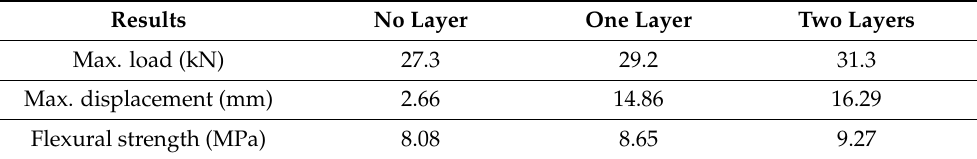
Figure 5. Results of flexural strength experiment. ( a ) Flexural strength. ( b ) Flexural strength ratio. Table 2. Experimental